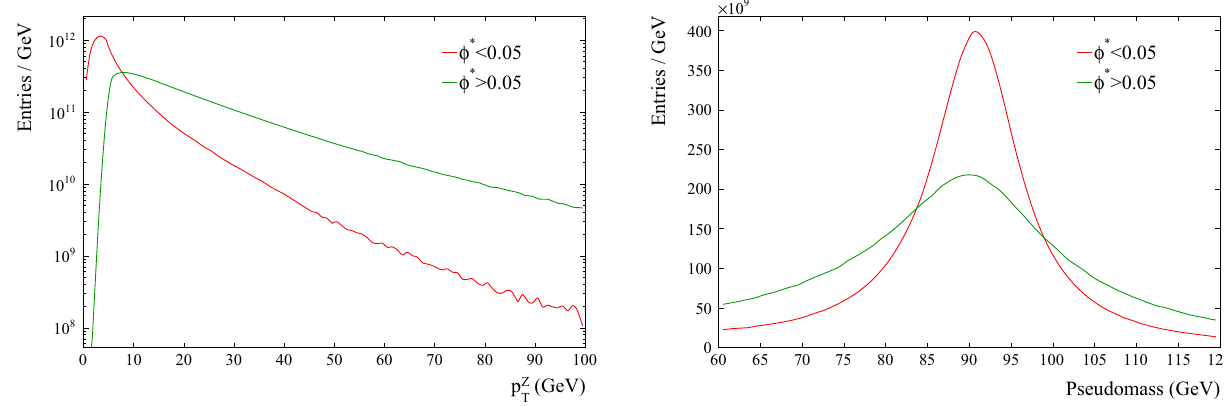
Fig. 1 The distribution of p Z (left) and the pseudomass (right) for events passing and failing the φ ∗ < 0 . 05 cut T